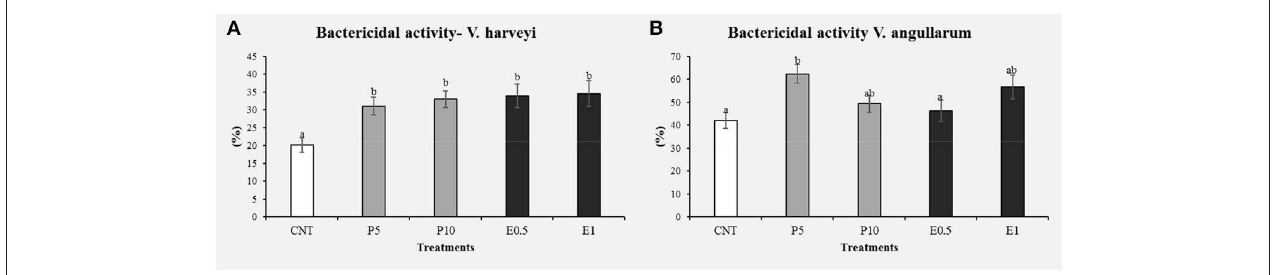
FIGURE 6 | Bactericidal activity against Vibrio harveyi (A) and Vibrio anguillarum (B) determined in the serum of S. aurata fed with pollen and SFE extract from pollen (CNT: control, P5: pollen 5%, P10: pollen 10%, E0.5: extract 0.5% and E1: extract 1%). Values are the mean ± SEM ( n = 9). Statistical differences ( P < 0.05) between groups are indicated by different